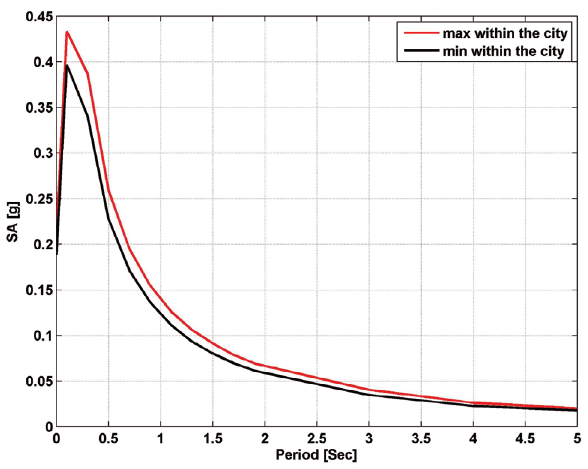
Figure 9. Estimated seismic hazard variation within the city for rock-site conditions (Vs30 = 900 m/s), for 10% probability of ex- ceedance in 50